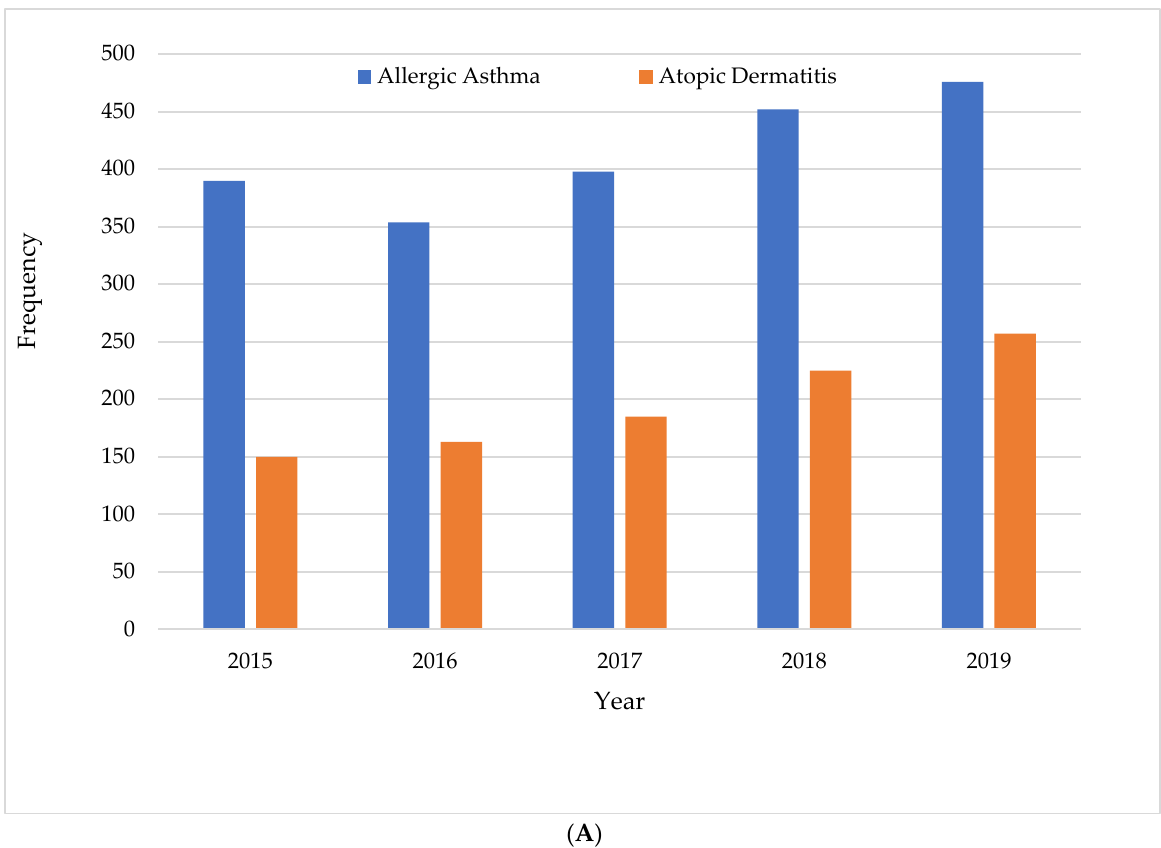
Figure 1. Flow chart for selection of the study population.